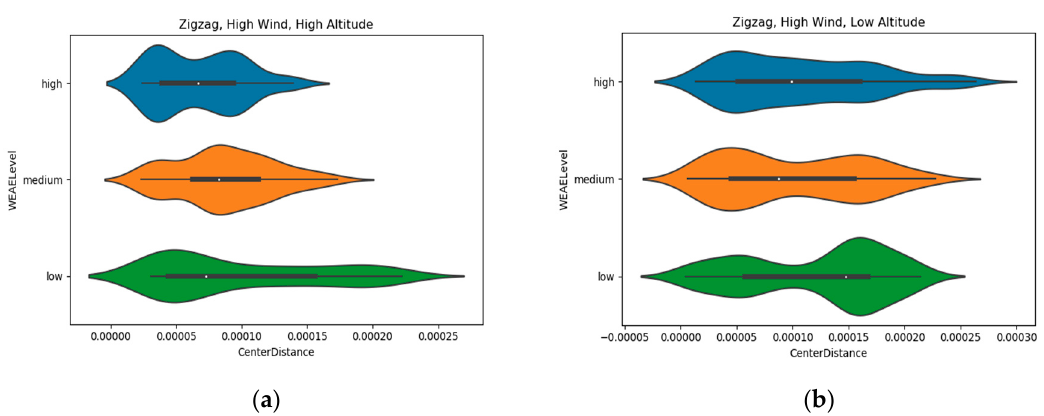
Figure 10. Occurrences of different gas measurements concentration levels at ( a ) high and ( b ) low altitude compared to distance of the location of the measurement and the center of the area explored, where the gas source was located.